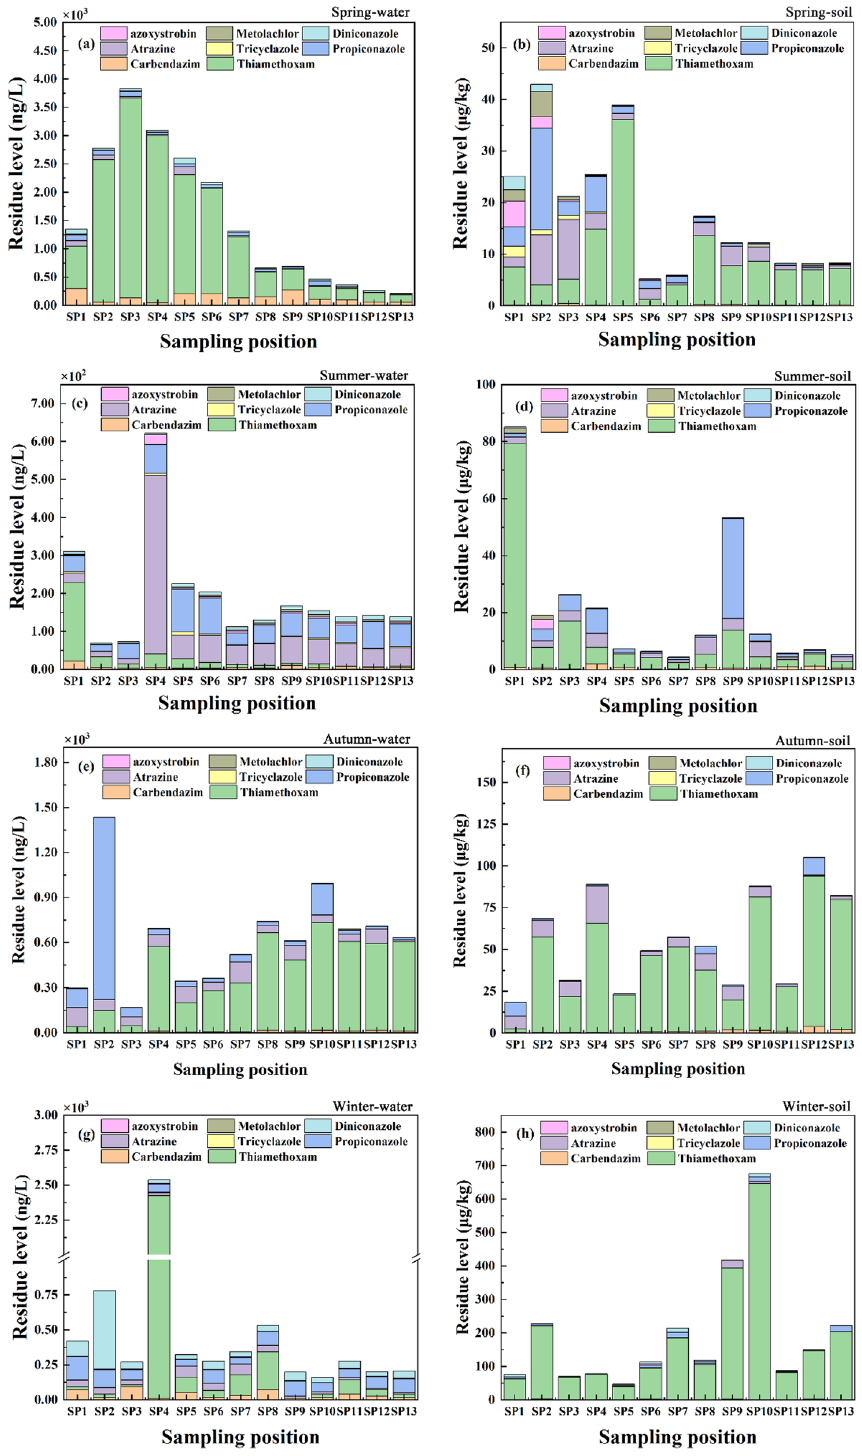
Figure 1. Residue level and range of eight pesticides in 13 sampling positions in different seasons. The residues were 0.250–3530 ng/L (water) and 2.79 × 10 −3 –647 μg/kg dw (soil), respectively. Thiamethoxam was dominant with the high-residue proportion (HRP, thiamethoxam residue/total residue) of 53–95% (water, HRP > 50%) and 63–97% (soil, HRP > 60%),